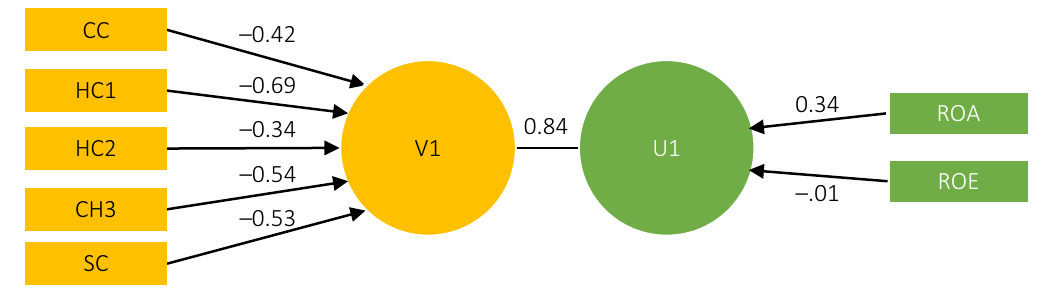
Figure 2. CCA between the first variate for the groups of